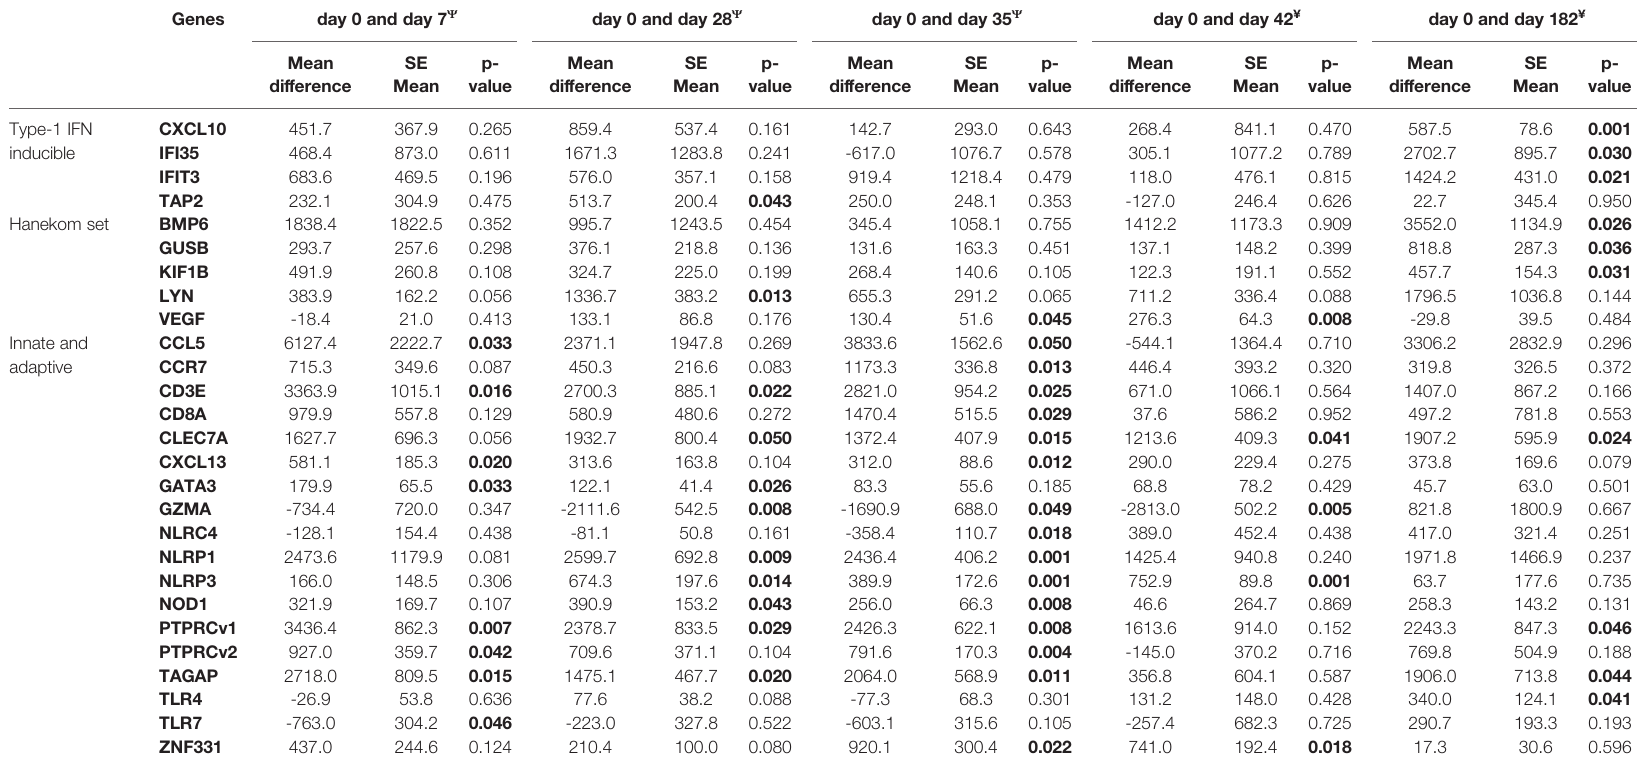
TABLE 5A | Comparison of baseline measurements of each biomarkers that changed with post-vaccination of AERAS-402.